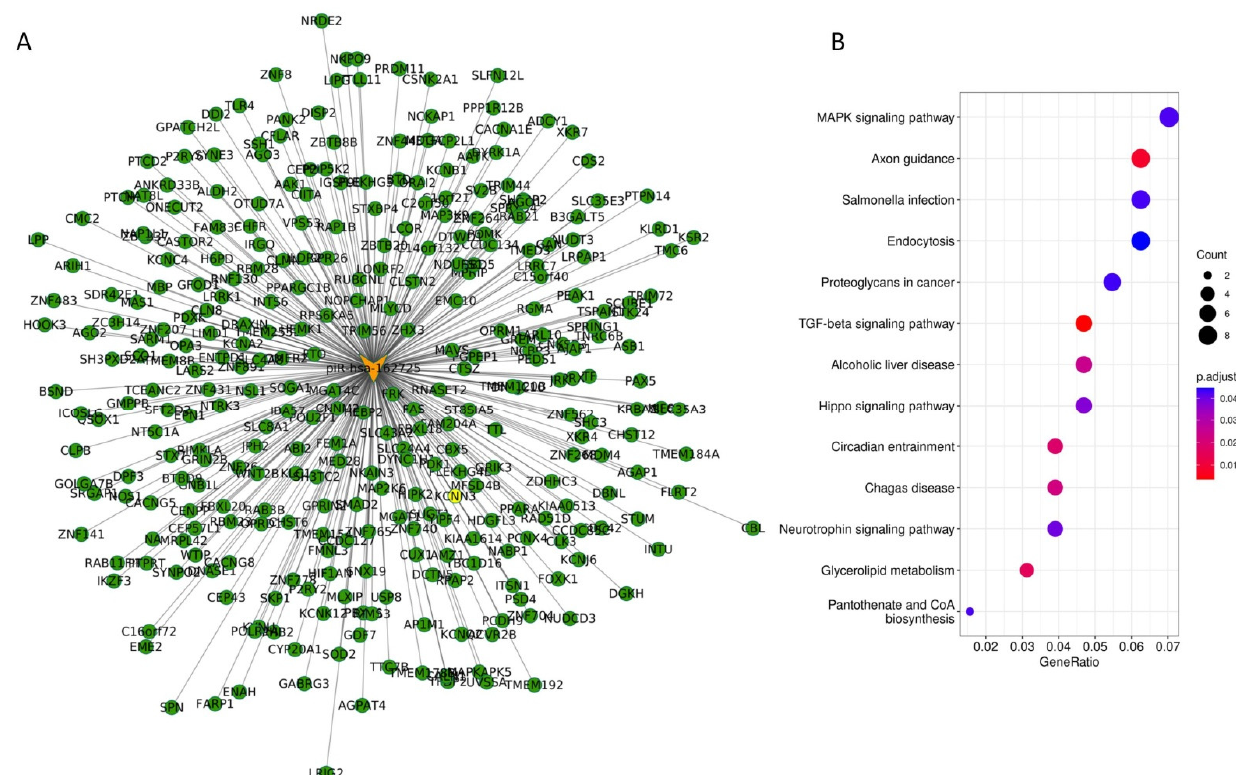
Figure 6. KEGG pathway analysis of piR-162725 highlights its potential as a modulator of the MAPK signalling pathway. ( A ) PiR-162725 -mediated KEGG pathway network showing putative mRNA interaction with piR-162725. ( B ) Dot plot of the top 13 KEGG pathways which were enriched in piR-162725 potentially modulated transcripts.